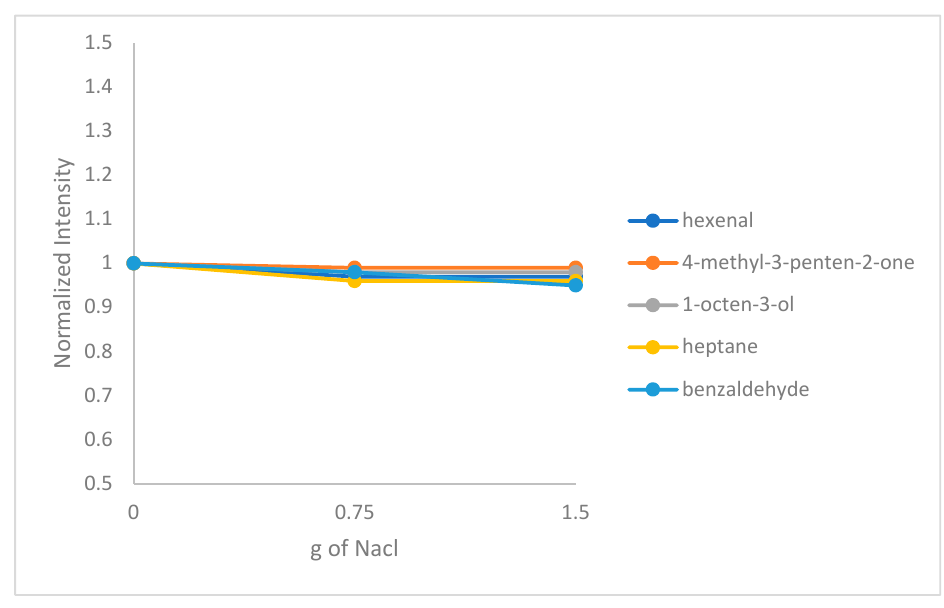
Figure 3. Effect of salt addition on hexanal, 4-methyl-3-penten-2-one, heptane, benzaldehyde and 1-octen-3-ol.